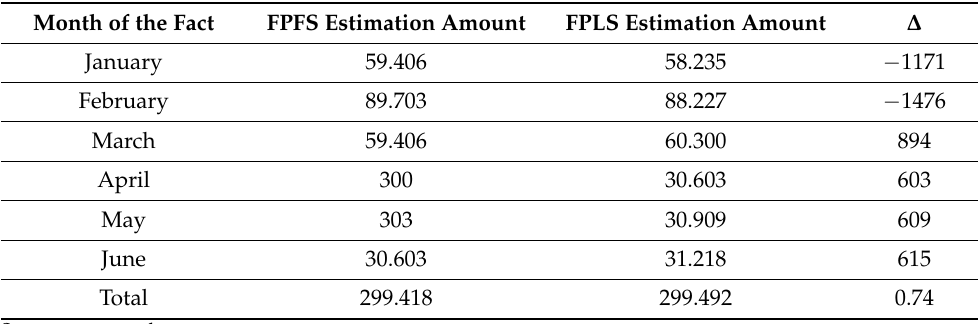
Table 7. Estimation of the differences in the discounted value of the fact of economic life by various ways of distributing nominal amounts between